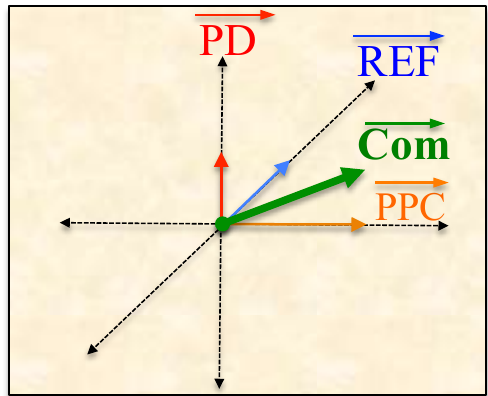
Figure 29. FVS of attributes (REF, PD, PPC) of object municipality